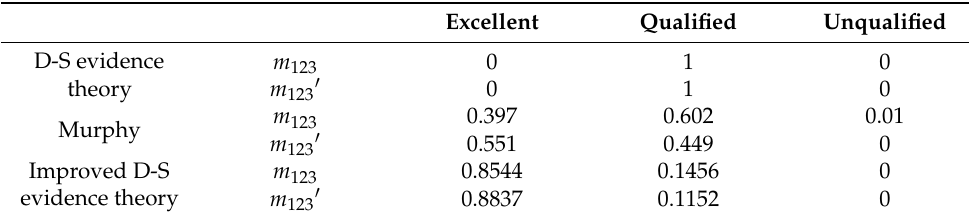
Table 8. Fusion results of three evidence-fusion methods. Excellent Qualified